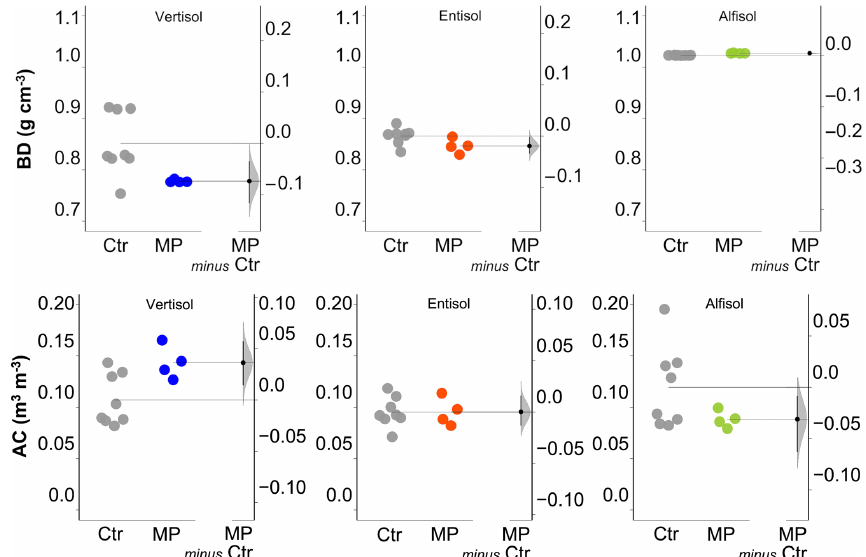
Figure 3. Soil bulk density (BD) and air capacity (AC). Raw data of the control (Ctr, gray dots) and polyester MP fibers added to the treatment (MP, colored dots) are shown in the plot for each soil. The filled curve indicates the resampled distribution of the mean differences ( (cid:49) ), given the observed data. Horizontally aligned with the mean of the test group, (cid:49) is indicated by the black circle. The 95% confidence interval of (cid:49) is illustrated by the black vertical line.